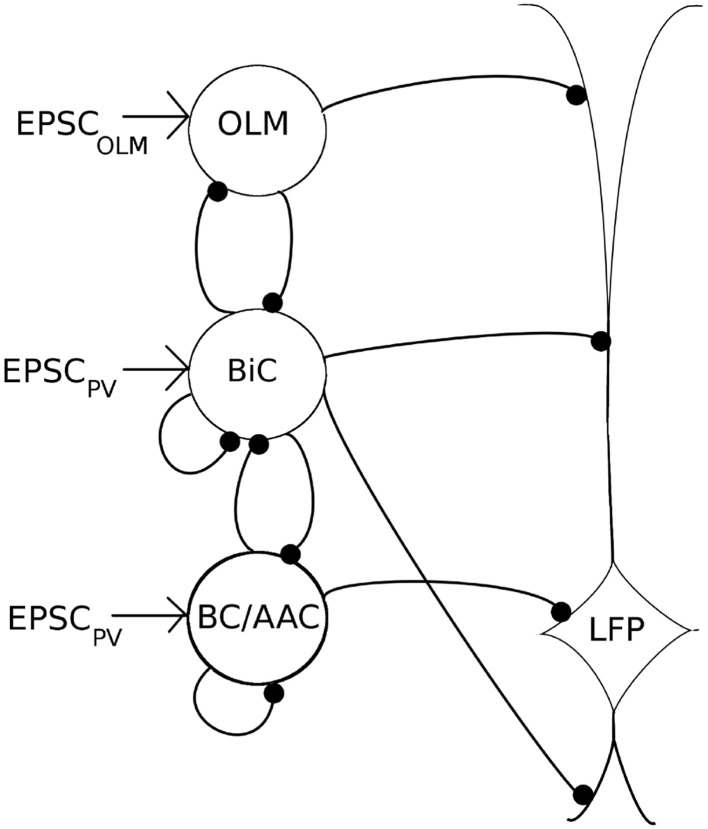
A schematic of our mathematical network model. The model contains OLM interneuron models, BiC models, and BC/AAC models. The number of cells (350 OLM, 120 BiC, 380 BC/AAC) and connectivity of each cell type is based on estimates derived from the literature. Filled in black circles represent inhibitory synapses. Each cell receives excitatory input that is taken from our experimental intracellular recordings of the respective cell types (EPSCPV and EPSCOLM). Each cell in turn innervates the LFP representation at the appropriate layer. Our LFP representation, which is a somatic recording of a passive PYR model (based on Migliore and Migliore, 2012), integrates these inputs. We use a spectral analysis of the LFP representation to determine the LFP power. As it remains unclear how connectivity between BiCs and OLM cells affects field activity, we have focused on these connections, varying connectivity and connection strength to determine their effects on LFP power.